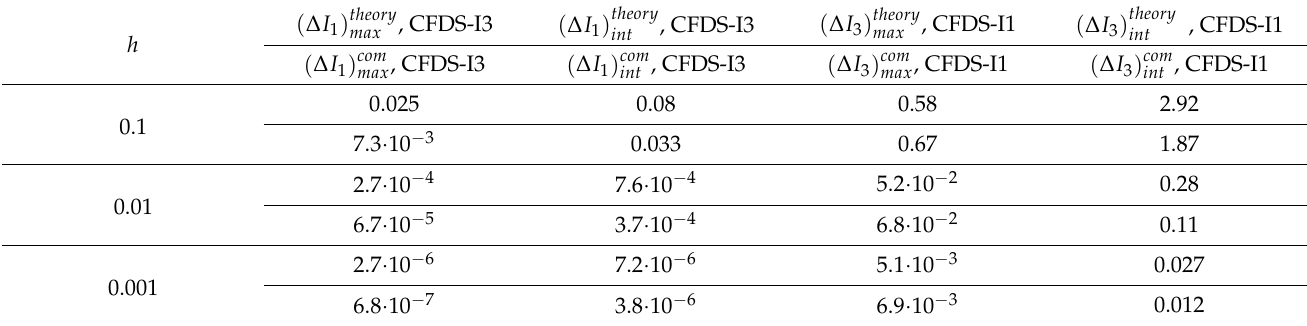
Table 1. Influence of the spatial step on the invariant deviation at constant mesh step on time τ = 10 − 3 .